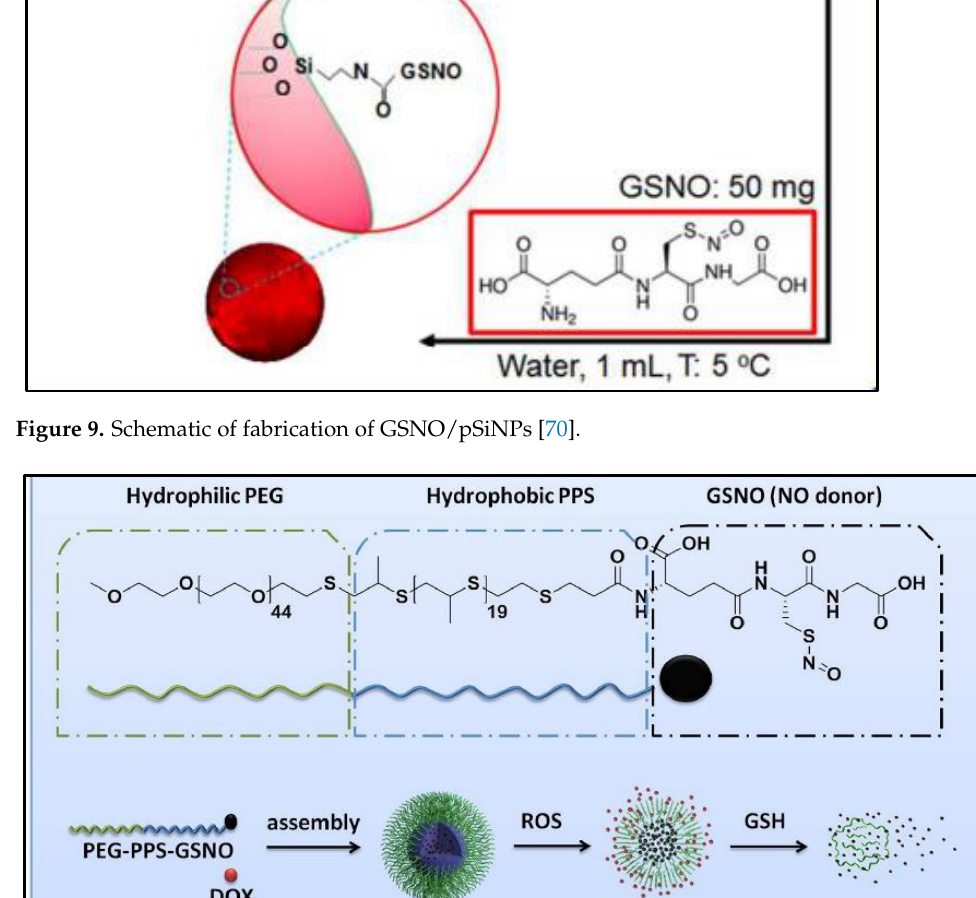
Figure 10. The scheme of co-assembly process of the conjugation copolymers [71].